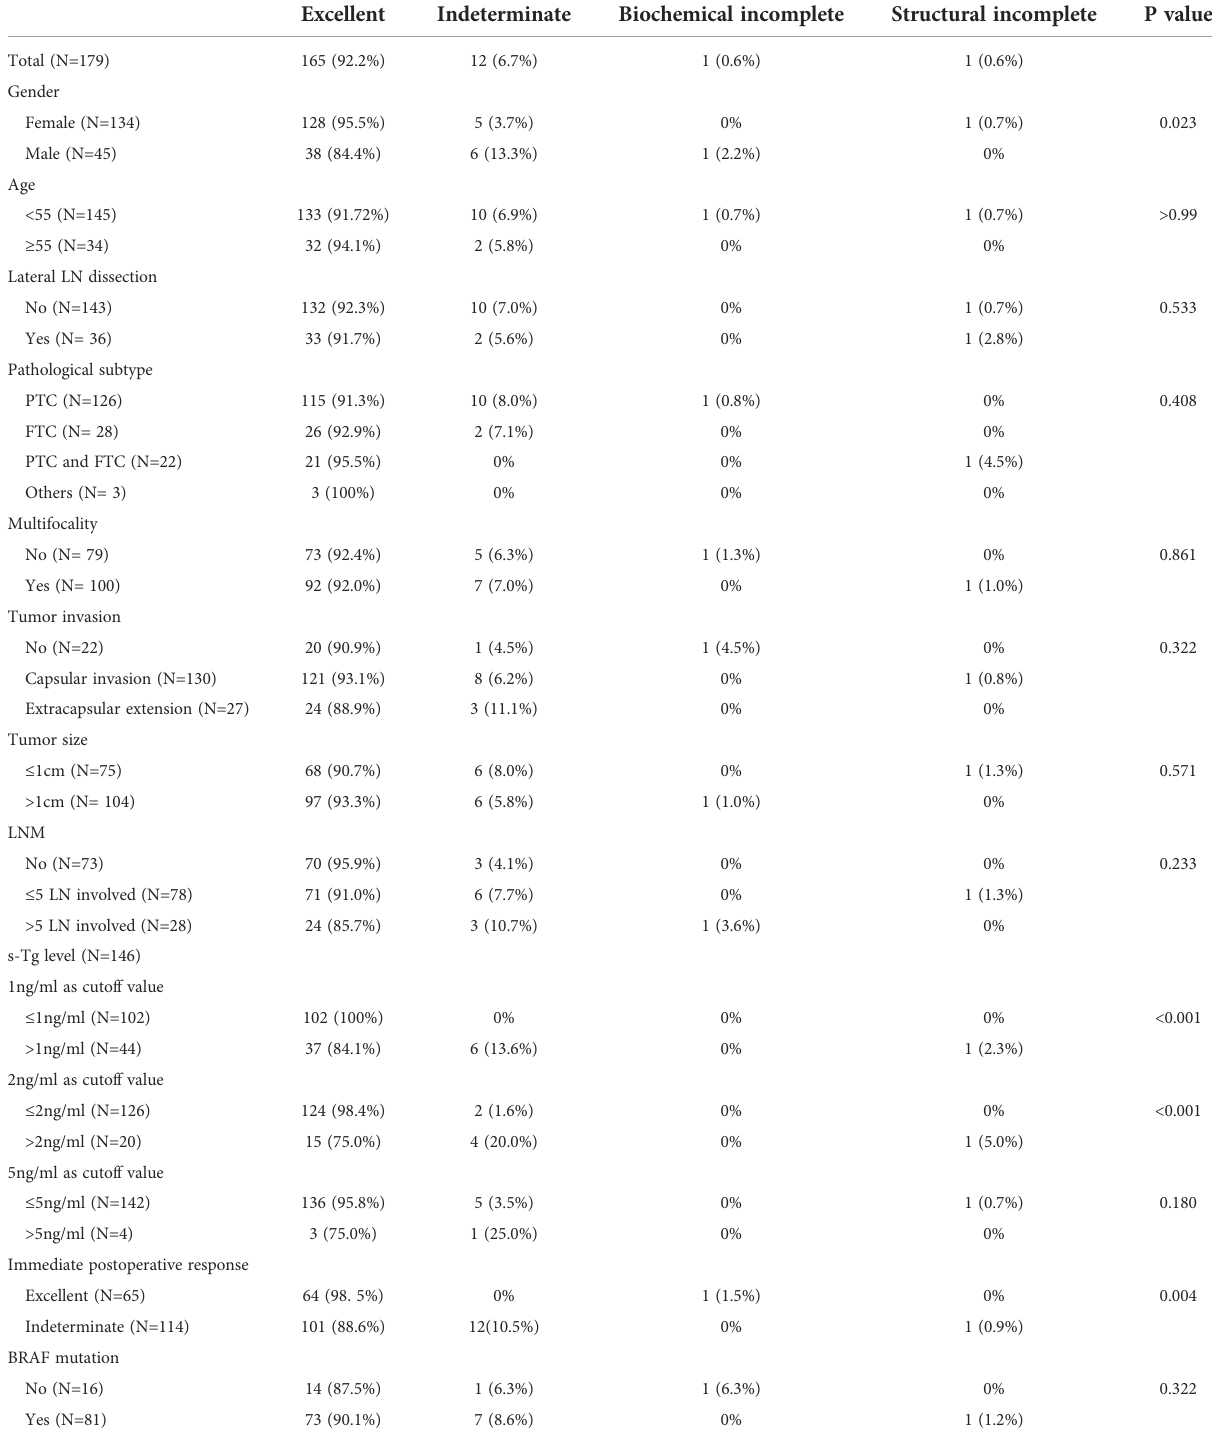
TABLE 4 Response to therapy at the last